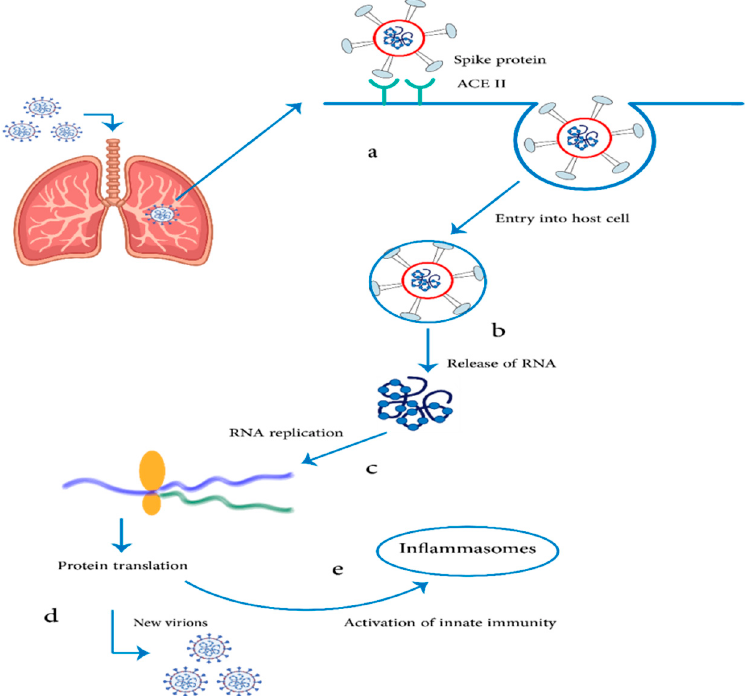
Figure 3. Schematic representation of the SARS-CoV-2 virus RNA. ( a ) SARS-CoV-2 virus enters the airway epithelial host cells by endocytosis through the ACE2 receptor. ( b ) Release of virus RNA into the cytosol. ( c ) Replication of the RNA through ribosomes. ( d ) Protein translation and formation of new virions. ( e ) Activation of innate immunity and release of inflammasomes such as T cells, IL-1, IL-6, IL-8, IL-21, and TNF- β . Table 1. Recent COVID-19 candidate vaccines and their status in clinical